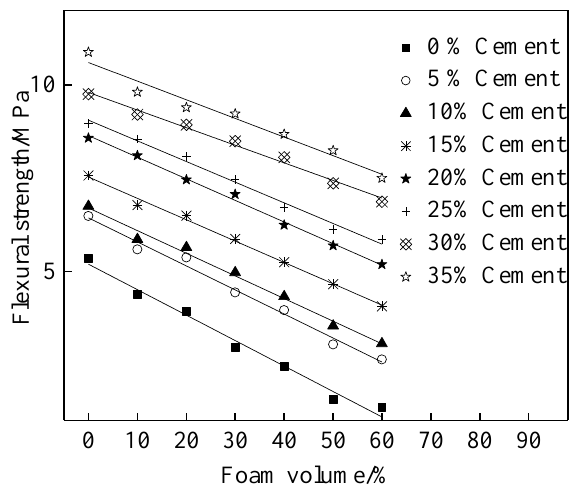
Figure 3. The relationship between flexural strength and foam volume.